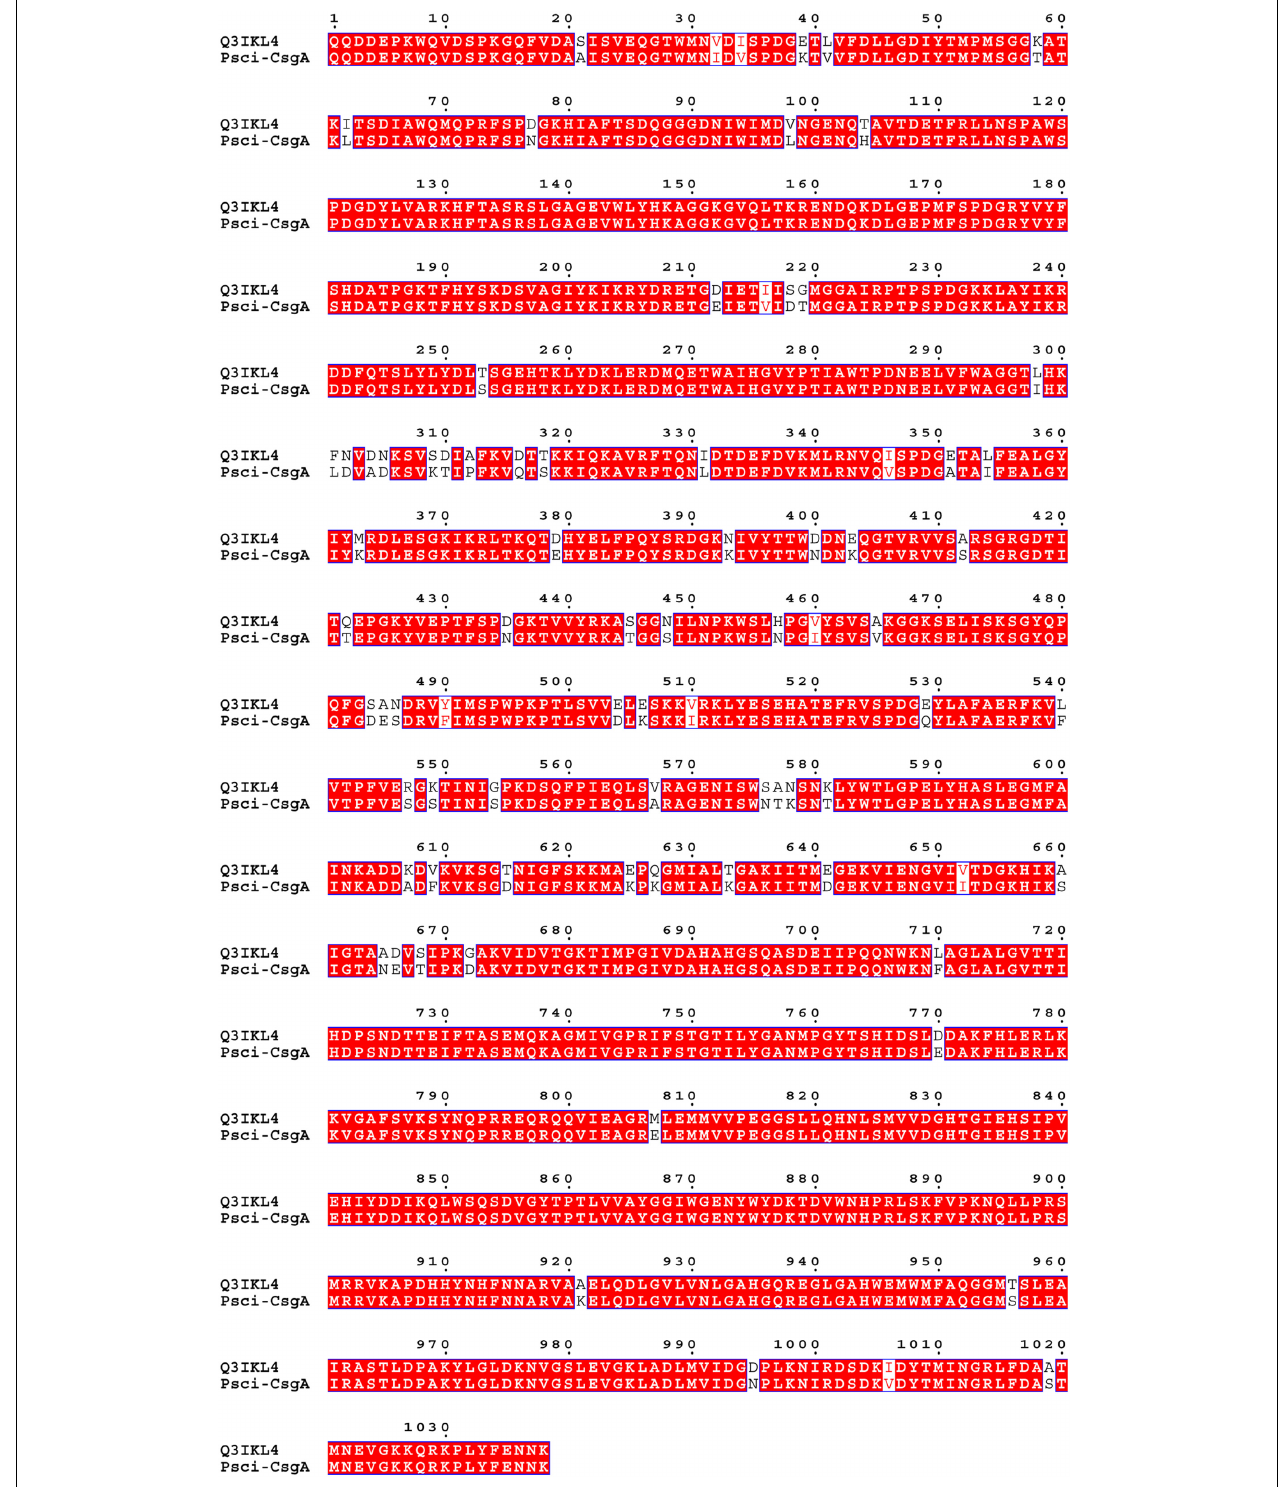
FIGURE 3 | Sequence alignment of Psc ι -CgsA and Q3IKL4_PSEHT from P. haloplanktis TAC 125 using the program MEGA 5. The ESPript 3 program (Robert and Gouet, 2014) was used to enhance the conserved amino acids which are shown in white letters on a red background.